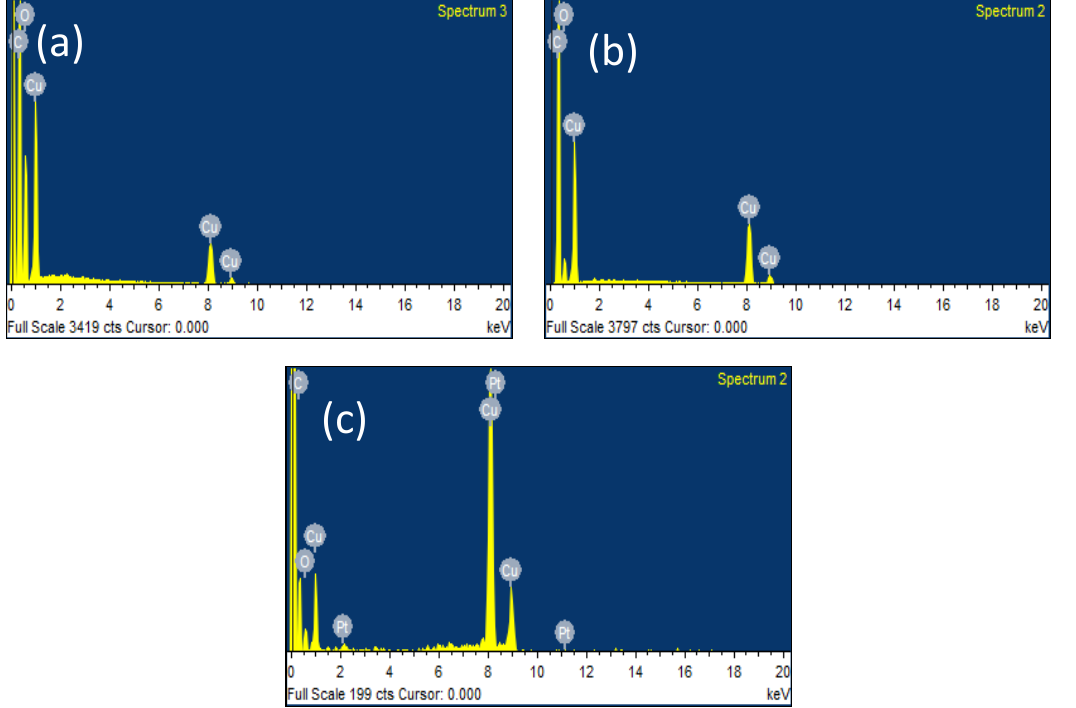
Figure 3. Energy dispersive X-ray spectroscopy of ( a ) Cu-tpa MOF, ( b ) Cu / NC, ( c ) CuPt / NC.